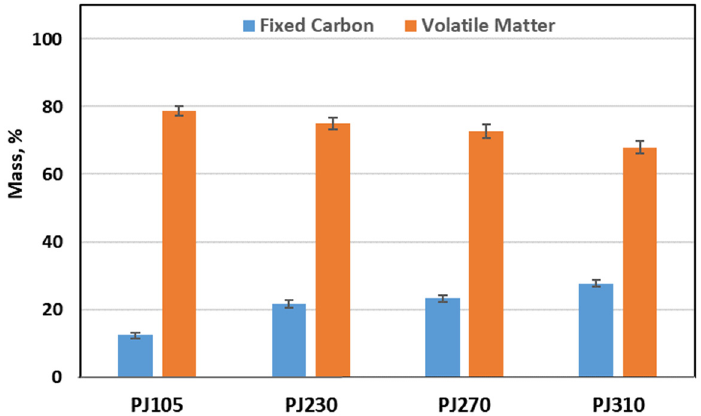
Figure 3. Profiles of the volatile matter and fixed carbon of P. juliflora samples.